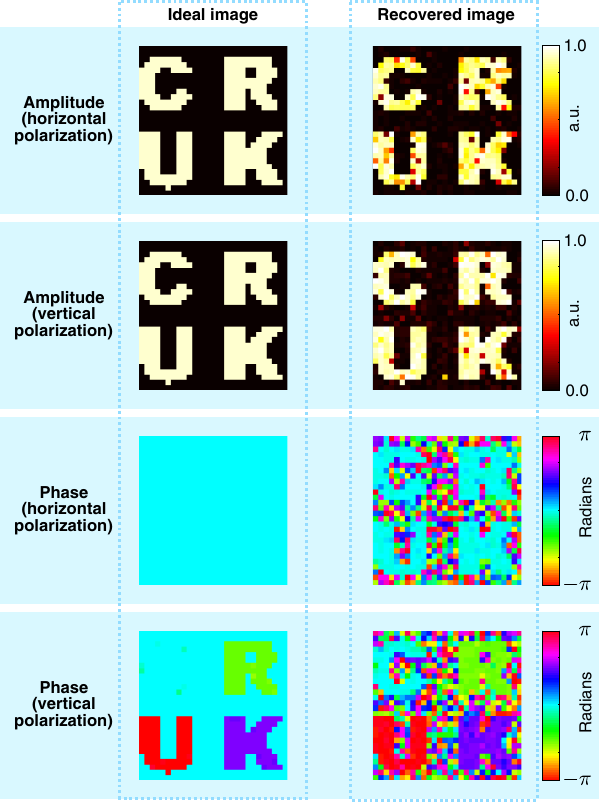
FIG. 7. Successful reconstruction of an amplitude, phase, and polarization image of a target at the distal facet using a TM recovered using the first-order model. The recovered image error is largely driven by illumination correction (see Sec. II E).